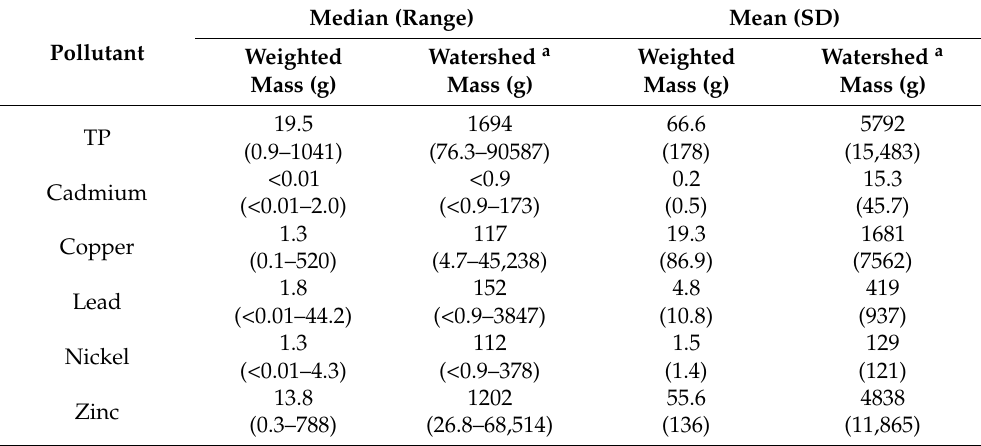
Table 4. Estimated mass in all septic systems in the studied sub-watershed ( n = 87) based on the median and mean concentrations of total phosphorus (TP) and trace metals from the studied septic tanks ( n = 37).